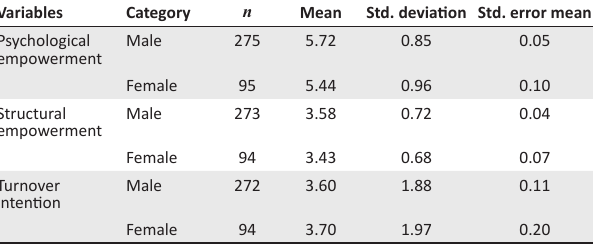
TABLE 6: Spearman’s rank correlation coefficient of work experience on structural empowerment, psychological empowerment and turnover intention. Variables